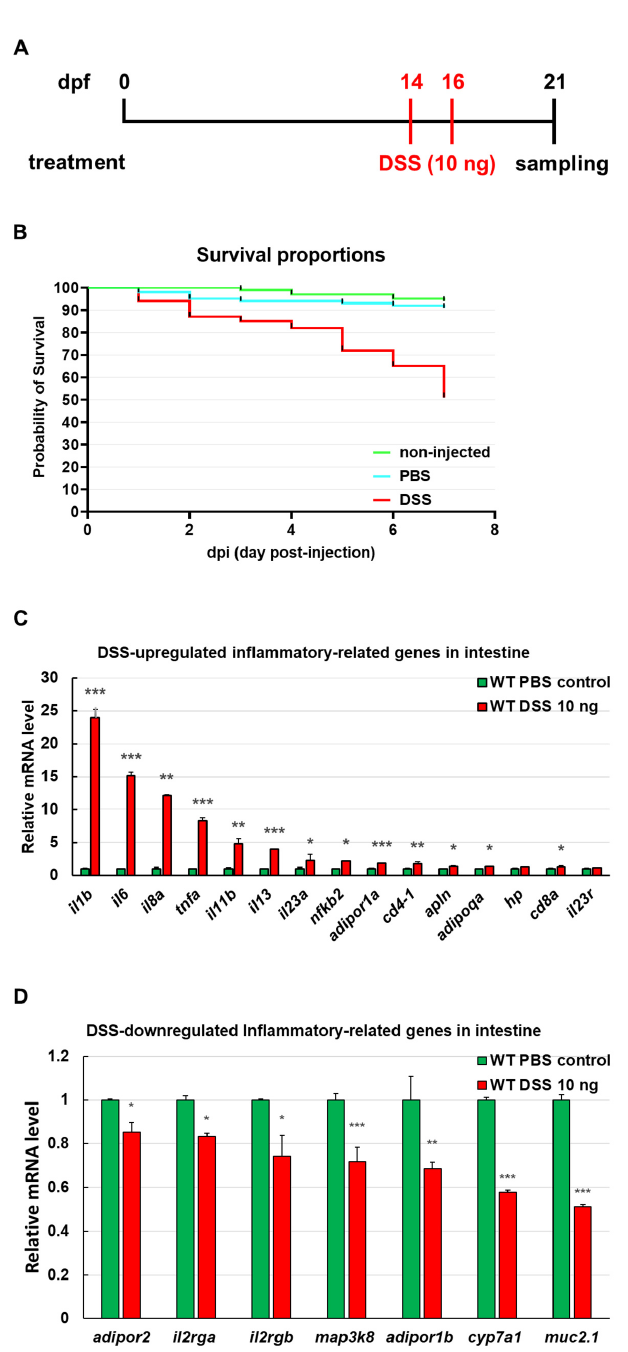
Figure 2. Identification of the gene markers of intestinal inflammation in zebrafish. ( A ) Schematic diagram of the dextran sodium sulfate (DSS) treatment strategy. Wild-type (WT) larvae were injected with PBS and 10 ng DSS twice at 14 and 16 days post-fertilization (dpf), and expression of the gene markers of intestinal inflammation was analyzed using RT-qPCR at 21 days post-fertilization (dpf). ( B ) Survival proportions of injected WT larvae from 0 dpi (days post-injection) to 7 dpi (14 to 21 dpf, p < 0.0001, n = 100 in three independent experiments). The survival rate of DSS-injected WT larvae was approximately 50%. The survival rates were not significantly different between non-injected and PBS-injected WT larvae (>90%). ( C , D ) RT-qPCR analysis of inflammation-related genes in the intestines of PBS- and DSS-injected WT lines at 21 dpf. mRNA expression levels were normalized to gapdh in the intestine of PBS-injected WT controls. Statistically significant differences from the PBS-injected WT control are denoted by * ( p < 0.05), ** ( p < 0.01), and *** ( p < 0.001) for all